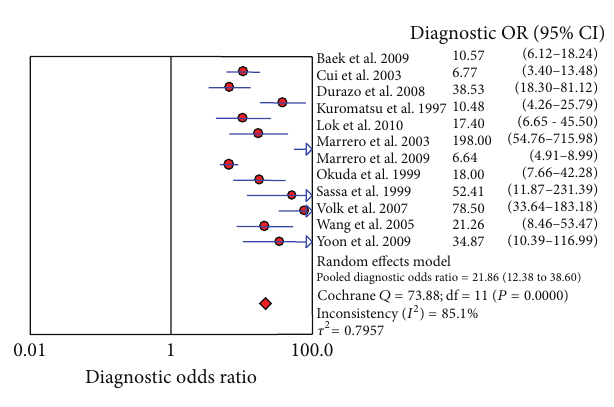
Figure 6: Forest map of